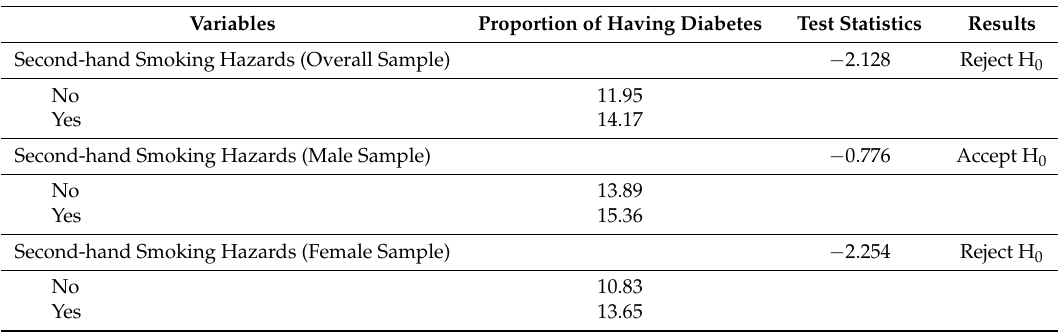
Table 5. Proportion Test of Having Diabetes for Each Variable.